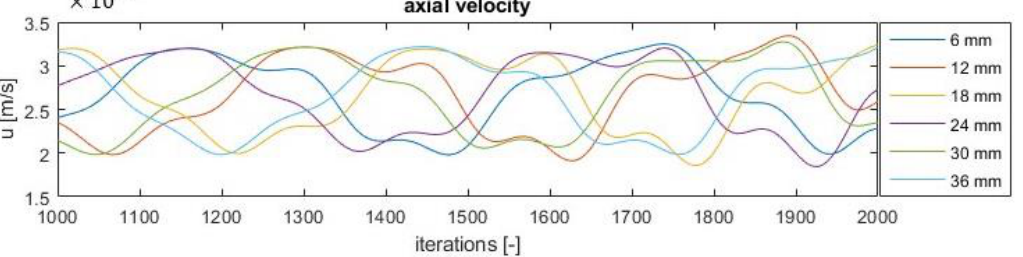
Figure 8. Axial velocity evolution at six points (locations indicated in the legend) after converged state is achieved in simulations with the initial model featuring initial domain span.